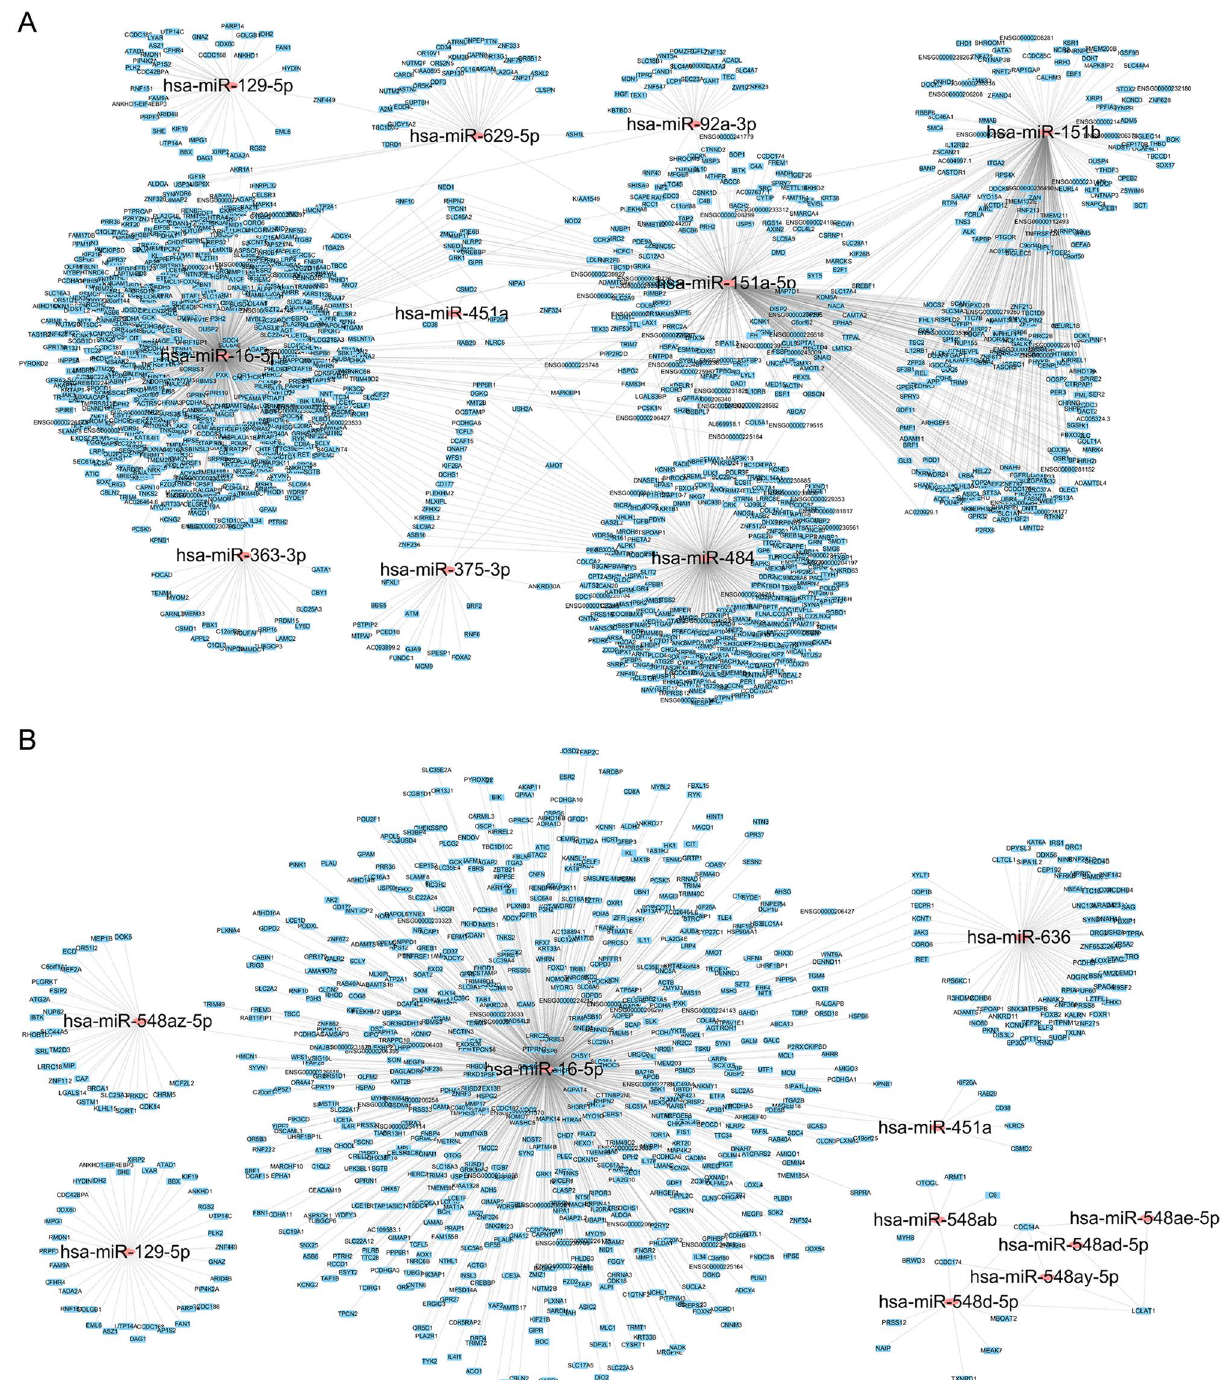
Figure 6. MiRNAs and mRNA interaction network analysis. ( A ) Top 10 DE-miRNAs from HCs vs HDPs along with the corresponding target genes were included in the network. Color corresponds to molecule type (miRNAs as red, mRNAs as blue). ( B ) Top 10 DE-miRNAs from HCs vs MDPs along with the corresponding target genes were included in the network. Color corresponds to molecule type (miRNAs as red, mRNAs as blue). HDPs Exosomes obtained from heroin-dependent patients, MDPs Exosomes obtained from methamphetamine-dependent patients, HCs Exosomes obtained from healthy